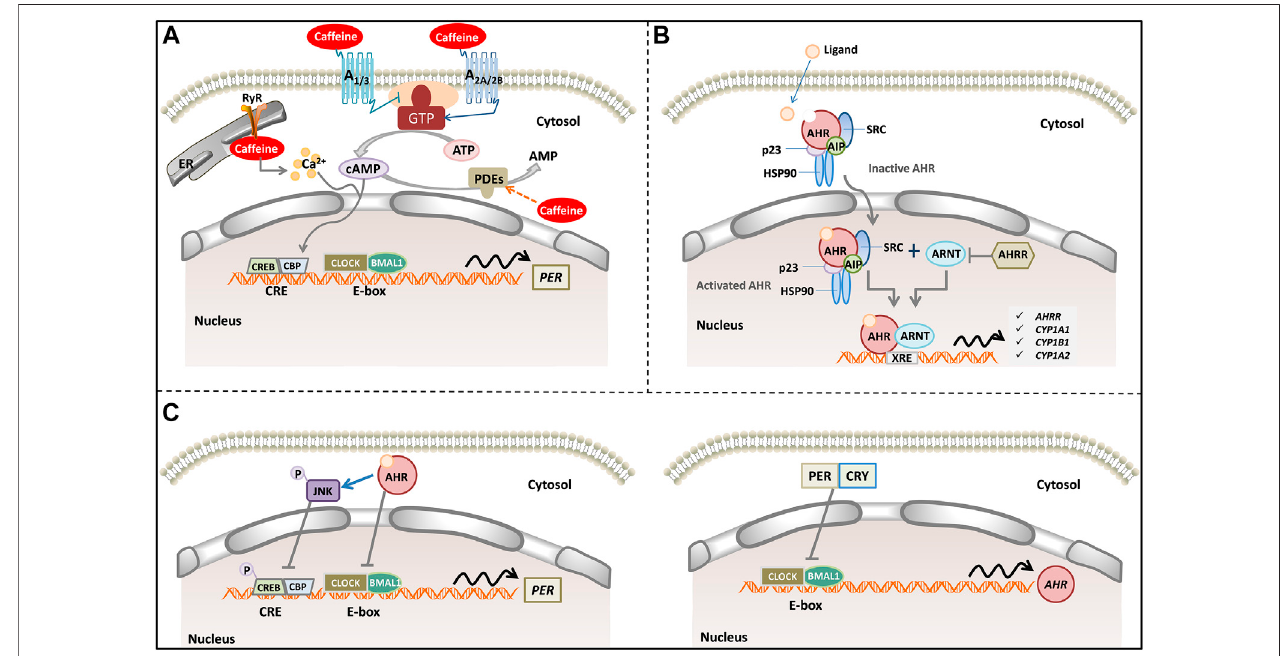
FIGURE 3 | A model of caffeine, AR signaling pathway, AHR signaling pathways, and human circadian clock. (A) Caffeine alters intracellular cAMP levels through bindingtoadenosinereceptors (A 1 ,A 2A ,A 2B and A 3 ) andinhibiting phosphodiesterases. Inaddition, caffeinemobilizesintracellularCa 2+ fromtheendoplasmicreticulum throughactivationoftheRyRchannels.IncreasedcytosoliccAMP/Ca 2+ signalingculminatesCREBactivationactingintandemwithrhythmictranscriptionalactivationby CLOCK/BMAL1. CLOCK/BMAL1 binds to E-box elements in the PER promoter, where they act to stimulate PER transcription. (B) Inactive AHR complexes with HSP90, AIP, p23 and SRCin the cytosol. Upon agonist binding, AHRand some components ofthe chaperonecomplex translocate tothe nucleus, where AHR forms a dimerwithARNTbindingtotheXREtocontrolgeneexpression(suchasAHRR,CYP1A1,CYP1A2andCYP1B1). (C) ActivatedAHRcanphysicallyinteractwithBMAL1, which exhibits high homology with ARNT, thereby reducing CLOCK-BMAL1 interactions and repressing PER transcription. In addition, activated AHR phosphorylates and activates JNK, which represses CRE-mediated transcriptional activity to suppress PER transcription (left). Rhythmic transcription of AHR is driven by CLOCK: BMAL1atE-Boxpromoterelements.PERandCRYinhibitAHRtranscriptlevels(right).Abbreviation:cAMP,cyclicadenosinemonophosphate;RyR,ryanodinereceptor; PDEs, phosphodiesterases; AHR, aryl hydrocarbon receptor; AHRR, AHR repressor; ARNT, AHR nuclear translocator; XRE, xenobiotic response element; HSP90, 90 kDa heat shock protein; AIP, AHR-interacting protein. CLOCK, circadian locomotor output cycles kaput; BMAL1, brain and muscle ARNT-Like 1; CREB, cAMP response element-binding; CBP, CREB binding protein; PER, periods; CRY,